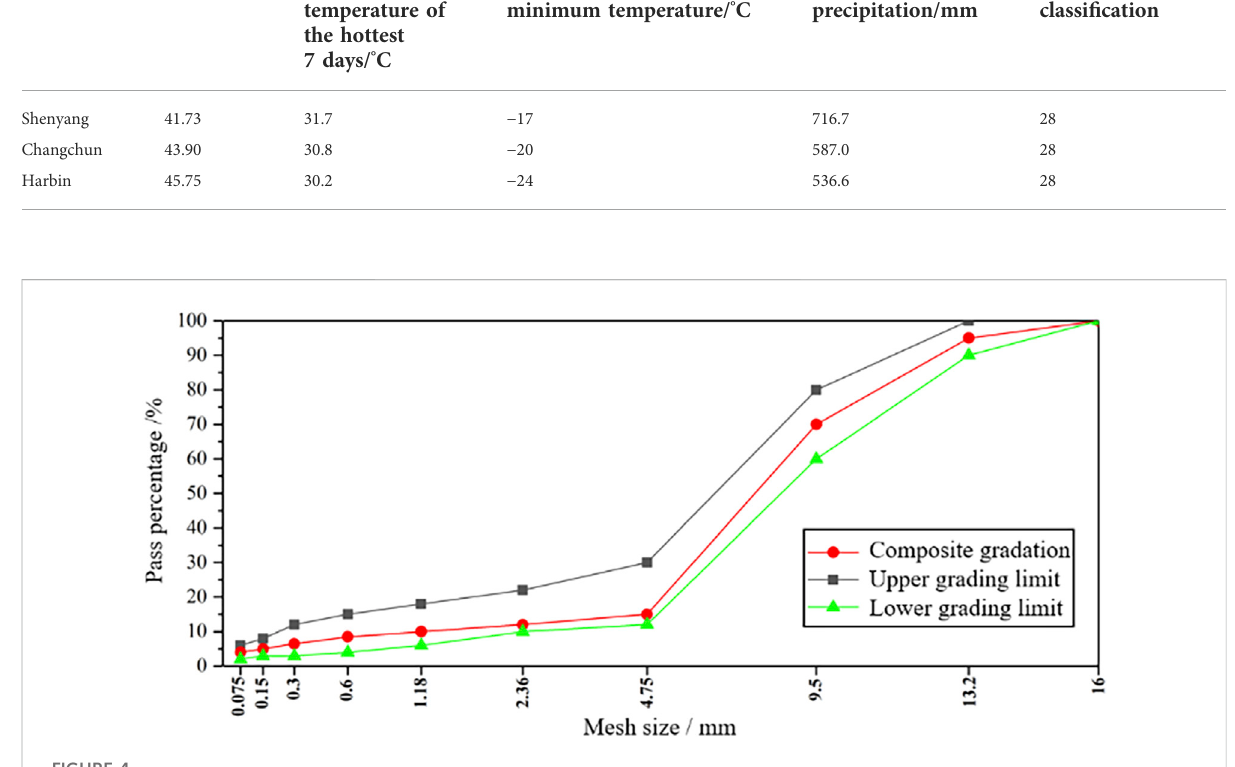
FIGURE 4 Gradation curve of permeable asphalt